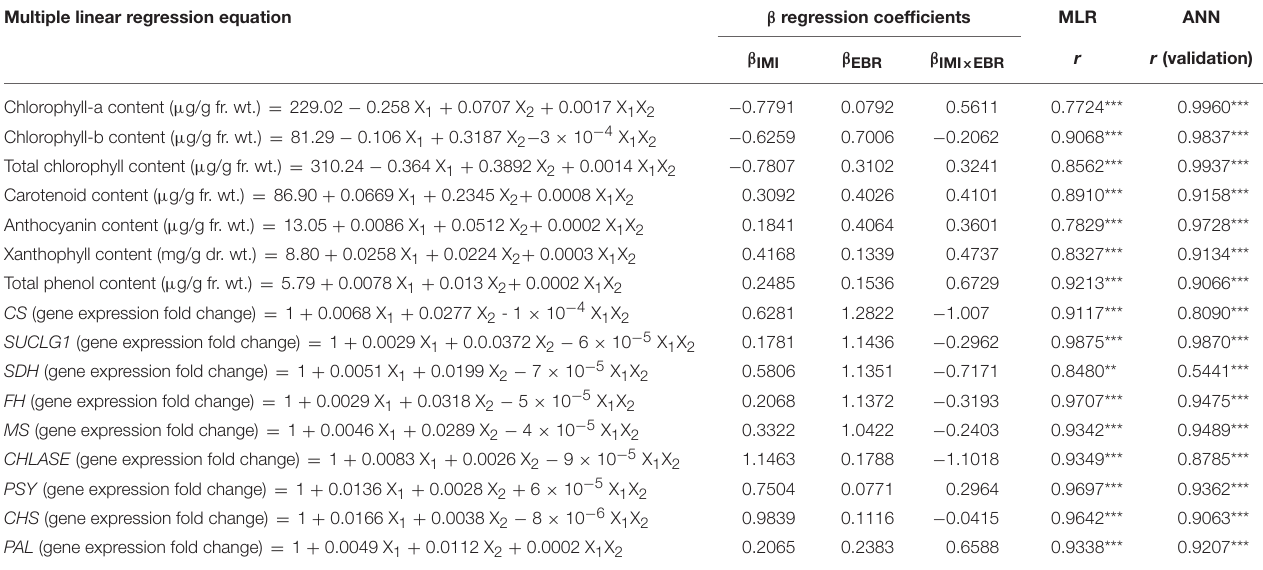
TABLE 4 | Multiple linear regression (MLR) and artificial neural network (ANN) analysis showing effect of seed soaking with 24-epibrassinolide (EBR) on pigments and total phenol contents, and gene expression in Brassica juncea seedlings grown under imidacloprid (IMI) toxicity. Multiple linear regression equation